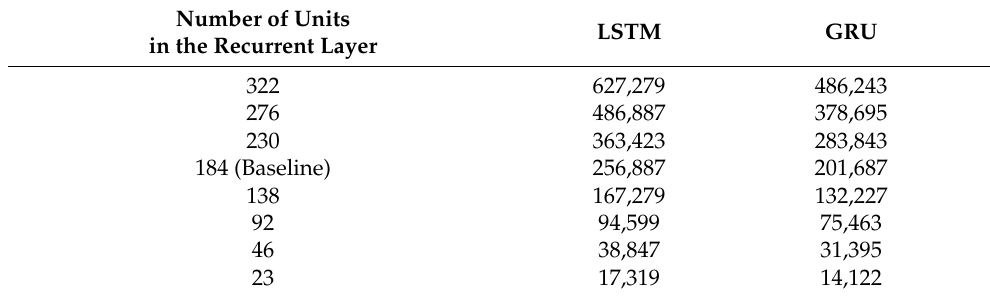
Table A10. Numbers of parameters of simplified or complicated recurrent neural network models.